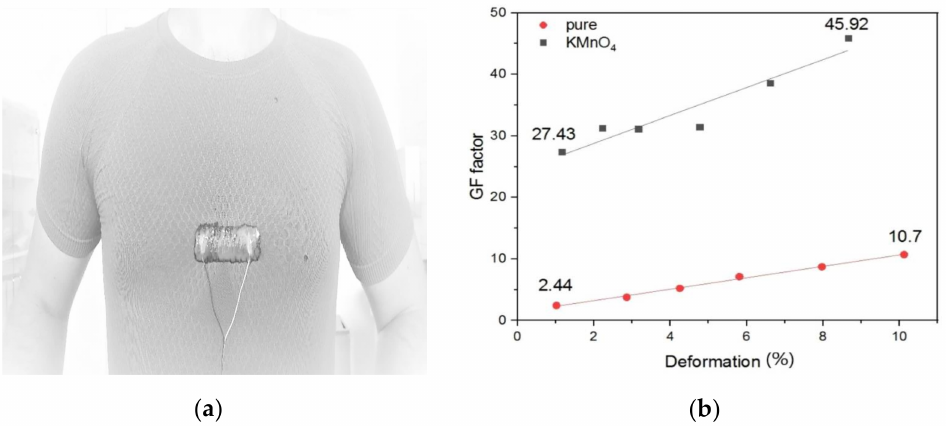
Figure 6. Gauge factor for MWCNTs (pure) and oxidized MWCNTs (KMnO 4 ) sensors as deformation increases ( a ); sensor with PU/oxidized MWCNTs applied to a commercial T-shirt ( b )